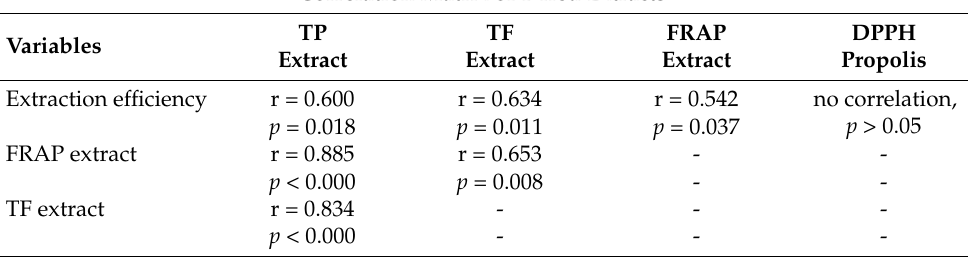
Table legends: - lack of